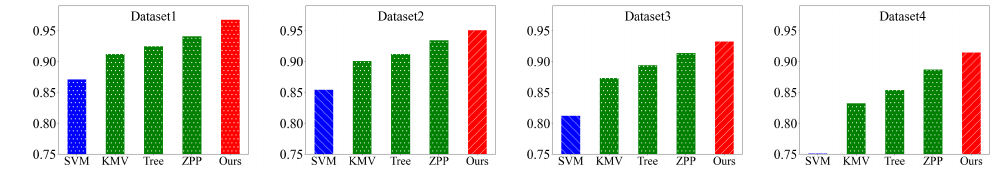
Figure 8. Accuracy in different